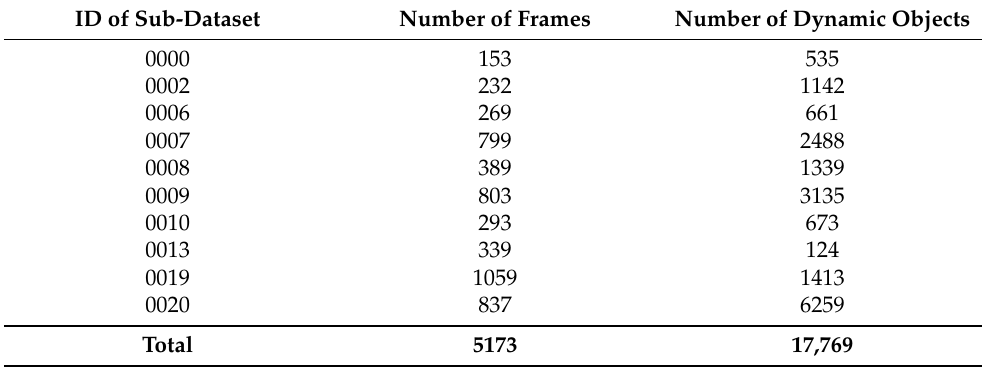
Table 1. Detail of the selected